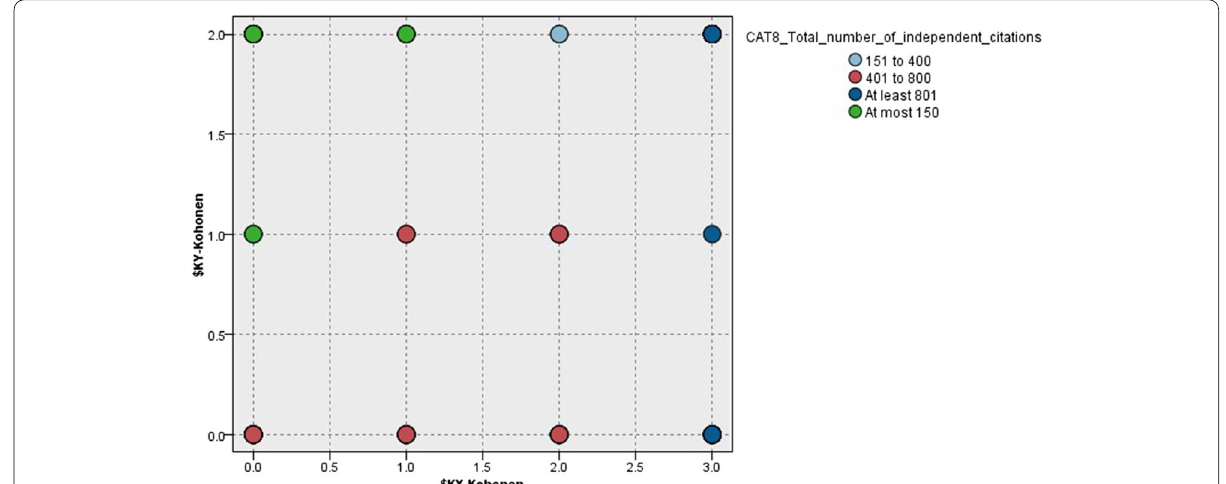
Fig. 5 Citation-based clusters according to the SOM model marked by the number of independent